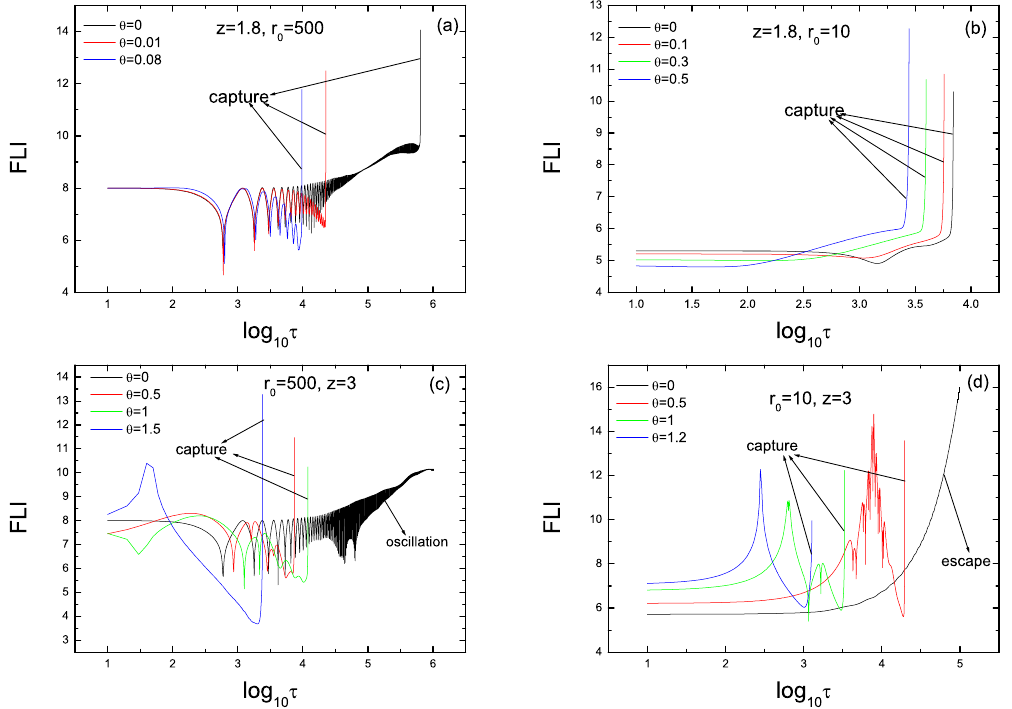
Figure 7 . FLIs for r 0 = 500 (left plots) and r 0 = 10 (right plots) with di(cid:11)erent z and (cid:18) at T = 0.